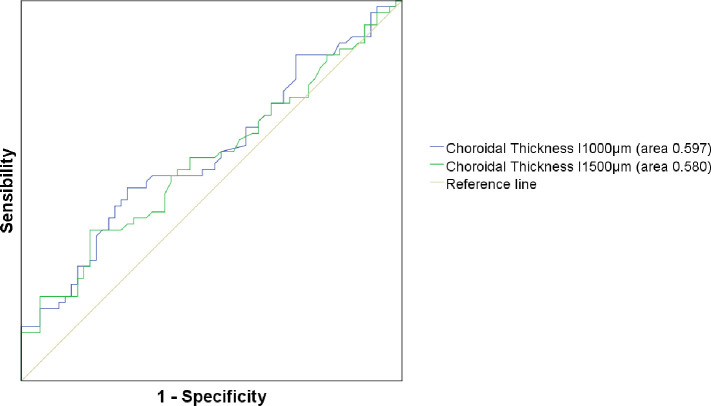
AUC of CT I1500μm and CT I1000μm.The area under the curve (AUC) of choroidal thickness (CT) at 1000 μm in inferior (I) (blue line) and at 1500 μm in inferior (green line) had the highest values under the curve and represented the most sensibility and specificity measurements.